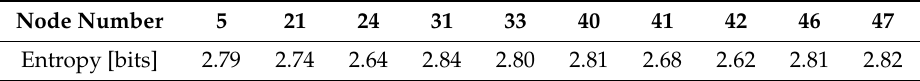
Table 10. Entropy values of 10 nodes in the correlated region (dataset 2 with N = 10